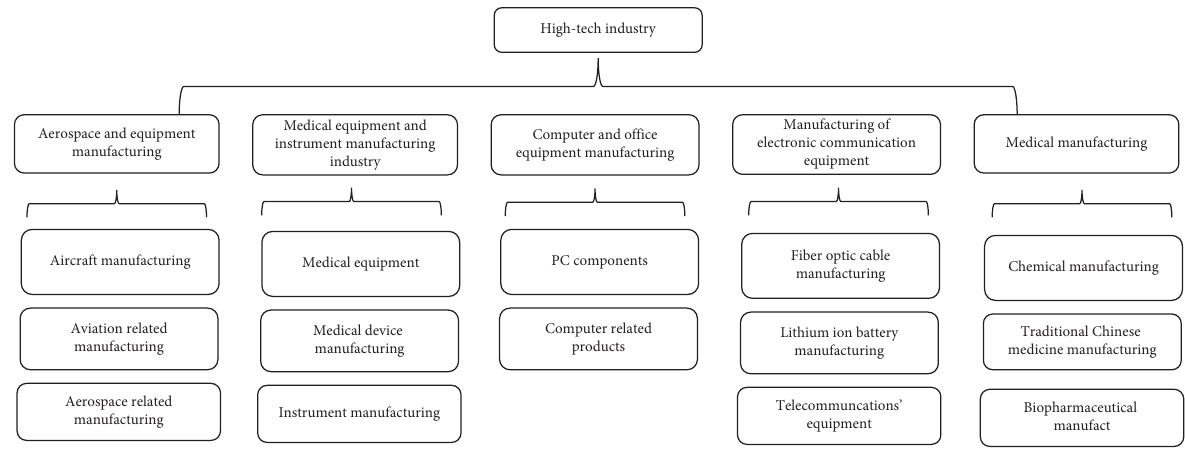
Figure 1: Classification of the high-tech industry in China. Source: statistical yearbook of China’s high-tech